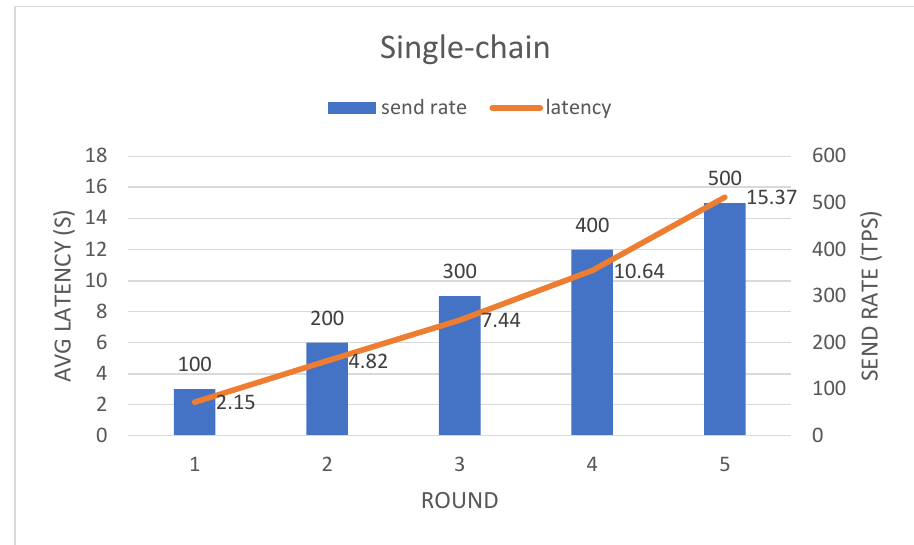
Figure 29. Network latency evaluation of single-chain architecture.